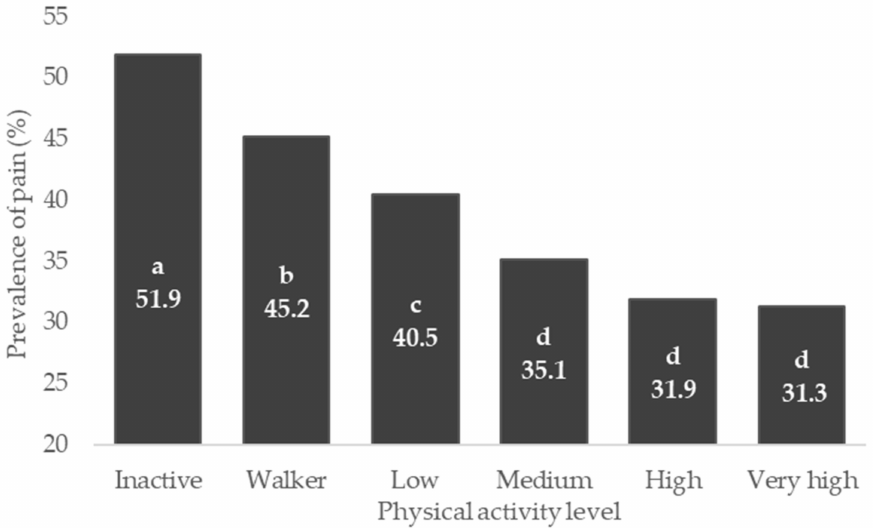
Figure 1. Prevalence of pain, according to physical activity level in general Spanish